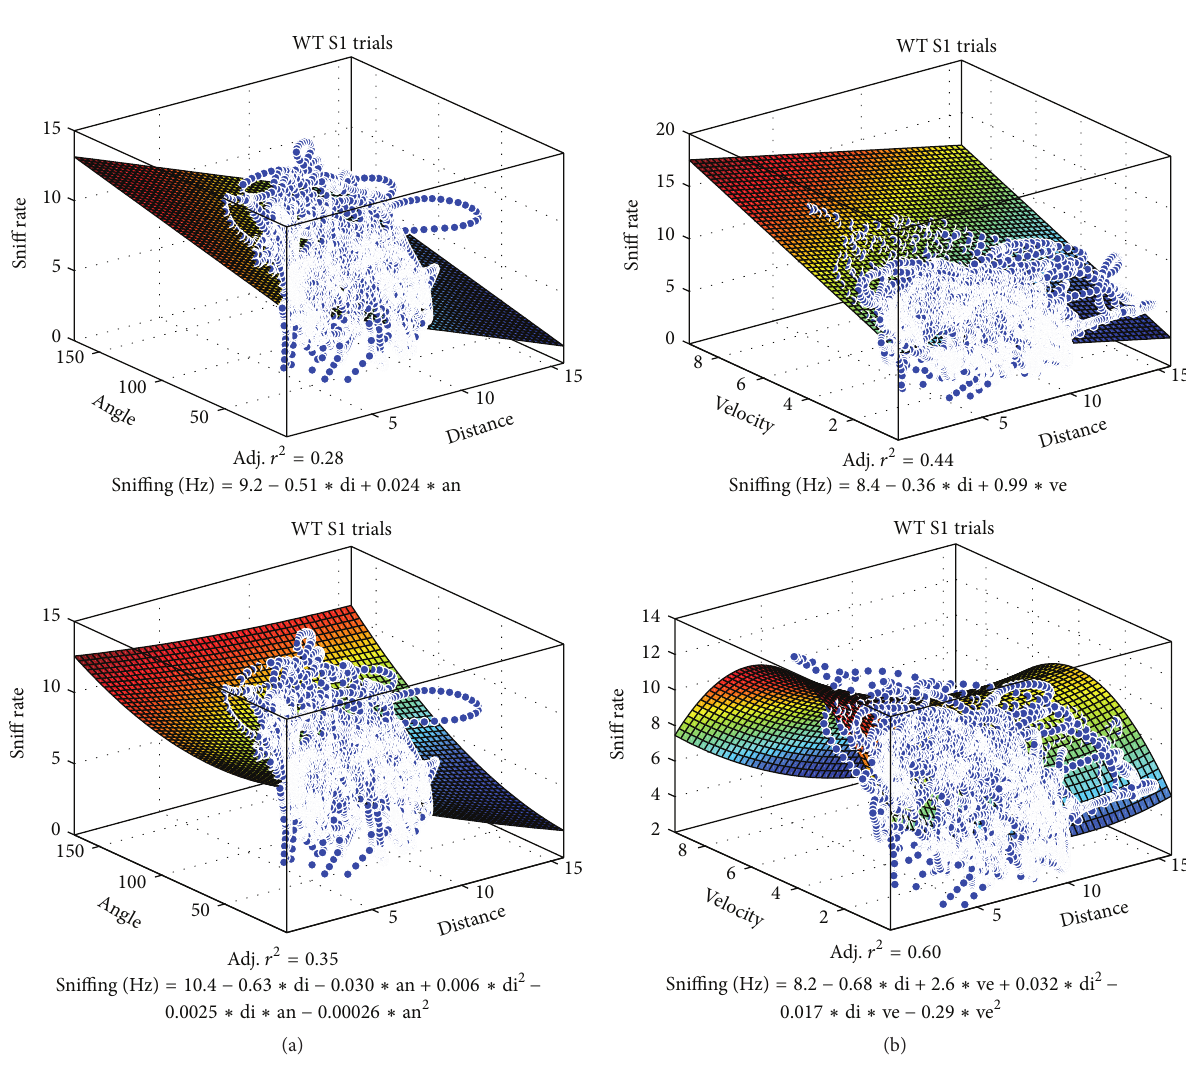
Figure 9: Distance and velocity combined predict sniff rates. Plots of the population vector sniff rates in state-space ((a) distance and angle; (b) velocity and distance) used in Figure 8 and the multiple regression equations and adjusted 𝑟 2 for all WT S1 trials combined (8407 time